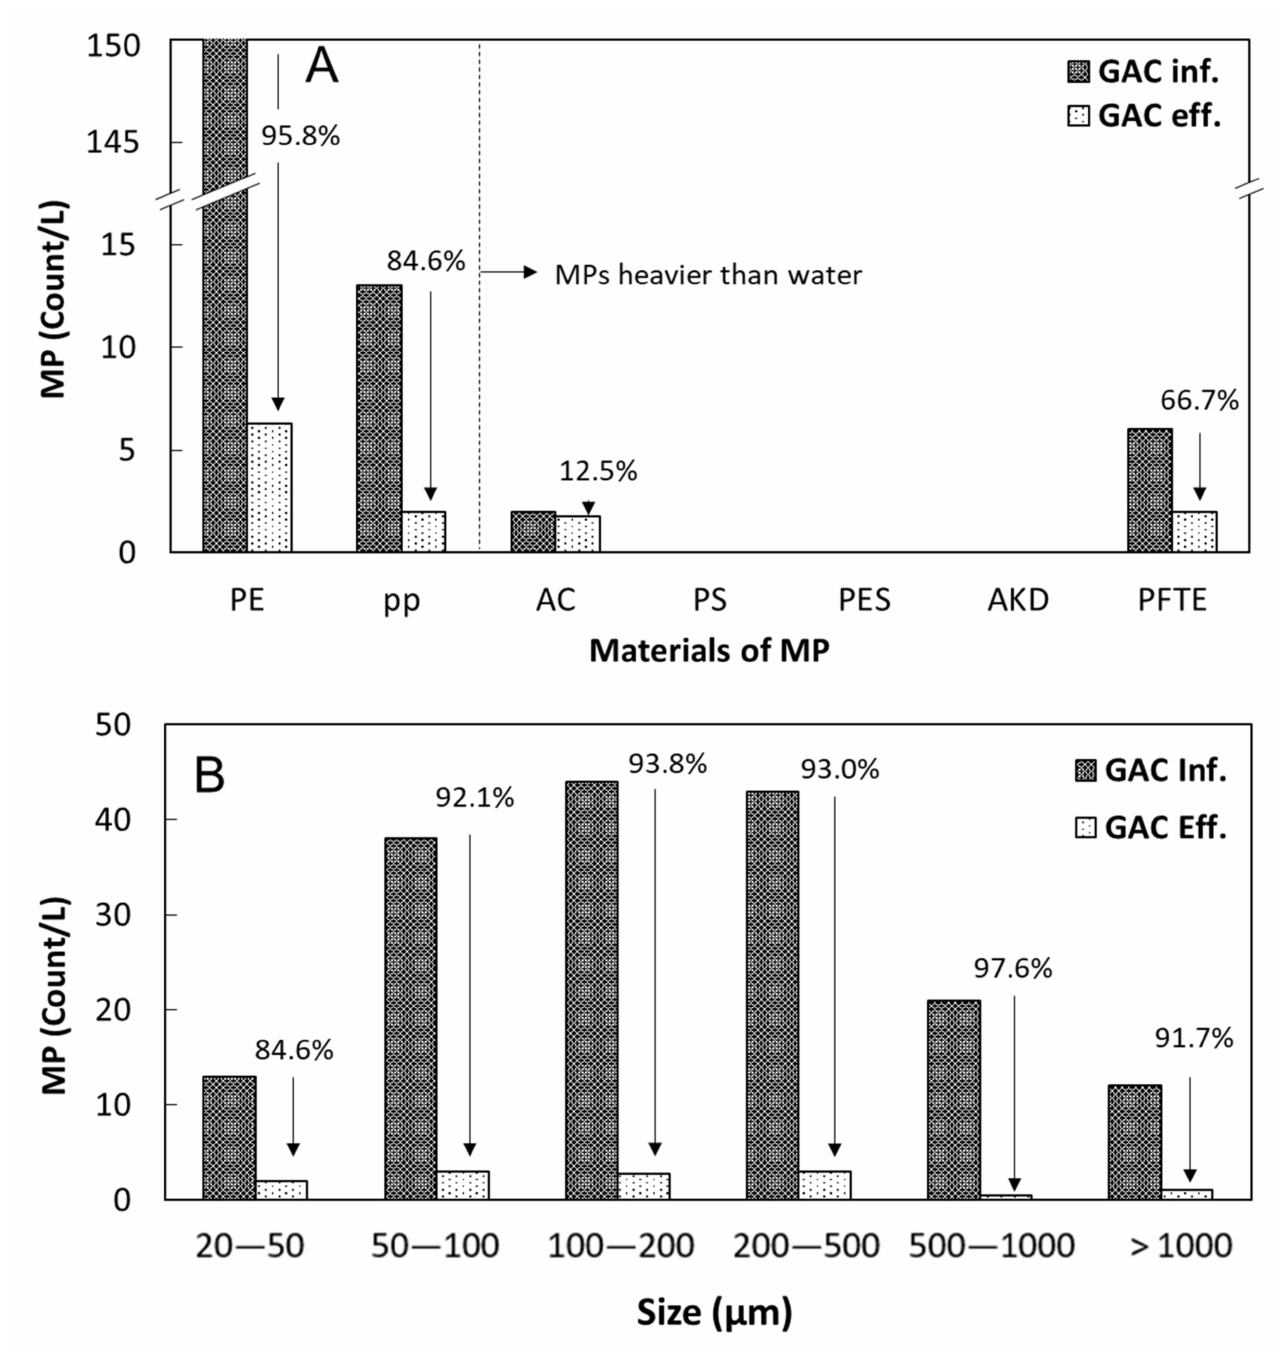
Figure 4. Removal efficiencies of MP particles by the GAC unit for ( A ) different materials and ( B ) different size ranges. PE: Polyethylene, PP: Polypropylene, AC: Acrylate, PS: Polystyrene, PES: Polyester, AKD: Alkyd, PTFE: